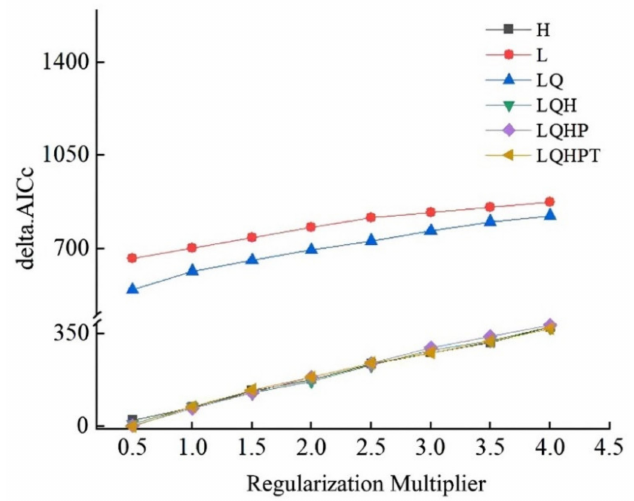
Figure 2. Evaluation metrics of MaxEnt model generated by